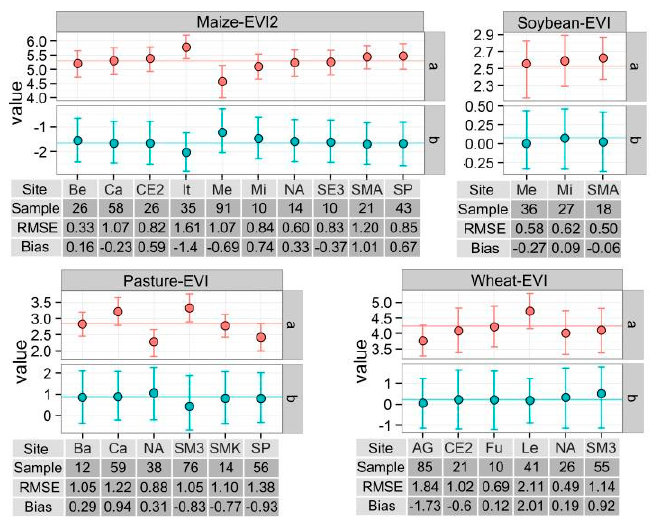
Figure 7. The variation of coefficient values from site-based validation for crop types with sufficient sample size: maize, soybean, wheat, and pasture. For each crop, the best model from Table 3 was used based on RMSE. Each site containing adequate samples (at least 10 samples) for a crop type is used once as a test site, while the rest sites serve in regression to obtain coefficient values. Coefficient values are plotted with filled circles corresponding to the test site displayed on the X axis. The horizontal line shows the value of coefficients (data from Table 3). The sample sizes, RMSE, and bias of each testing site are displayed in tables under X axis. The short names for each site are used on X axis: AG: AGRISAR,